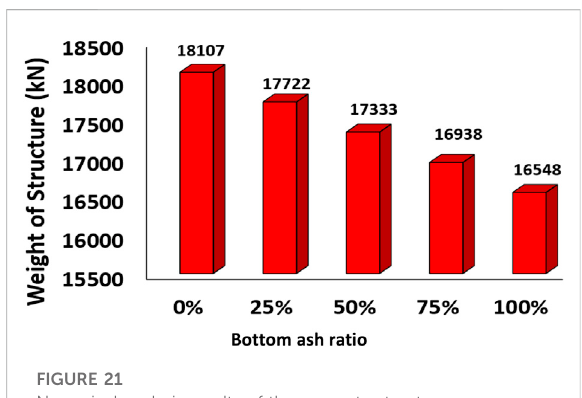
FIGURE 21 Numerical analysis results of the concrete